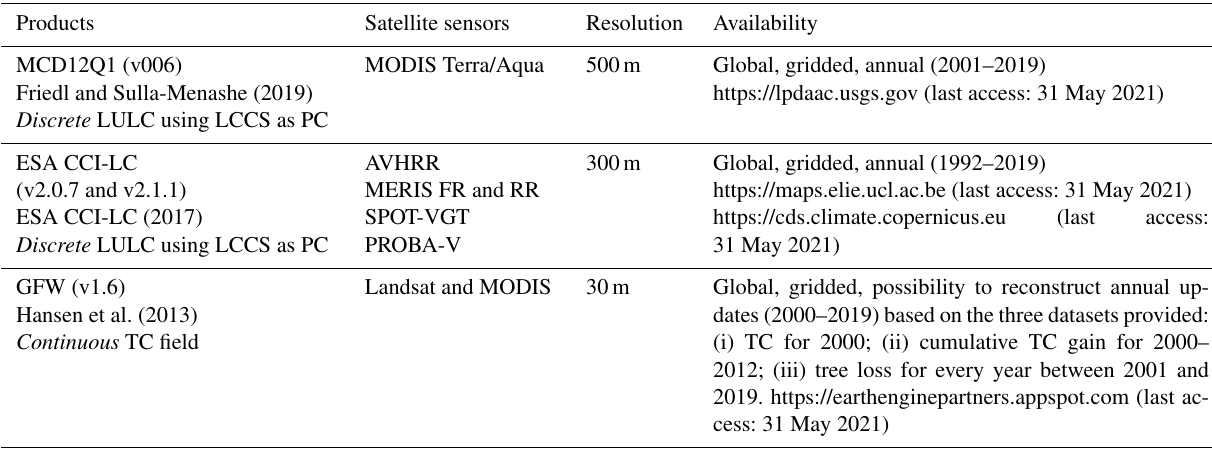
Table 1. Main features of the satellite vegetation products used for the comparison of land cover maps. Discrete LULC products, namely MCD12Q1 and ESA CCI-LC, rely on a primary classification (PC) such as the LCCS, standing for Land Cover Classification System. Details are found in Sect. 2.2.